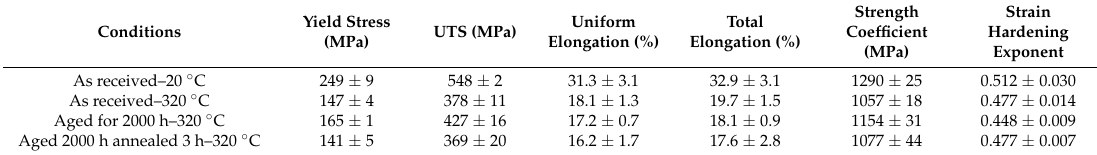
Mechanical properties of the tested Z3CN20-09M CDSS with different heat-treatment